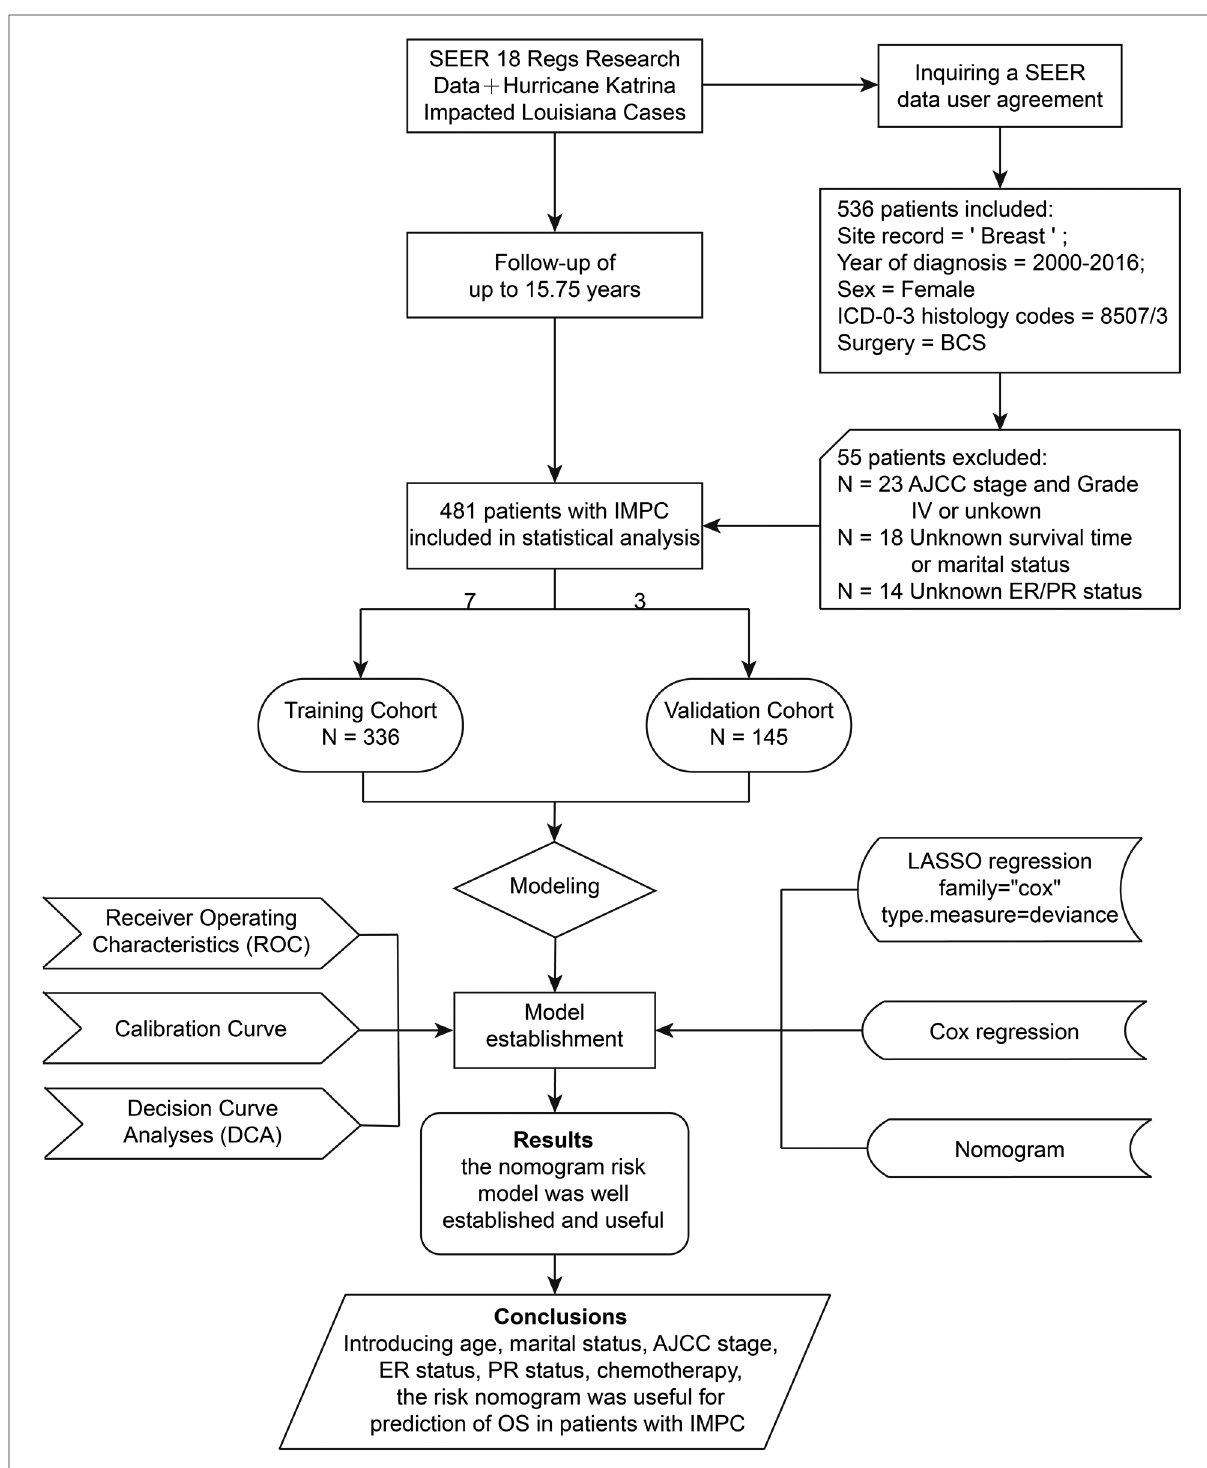
FIGURE 1 Flowchart of the study design. AJCC, American Joint Committee on Cancer; BCS, breast-conserving surgery; ER, estrogen receptor; IMPC, invasive micropapillary carcinoma; LASSO, least absolute shrinkage and selection operator; OS, overall survival; PR, progesterone receptor; SEER, the Surveillance, Epidemiology, and End Results